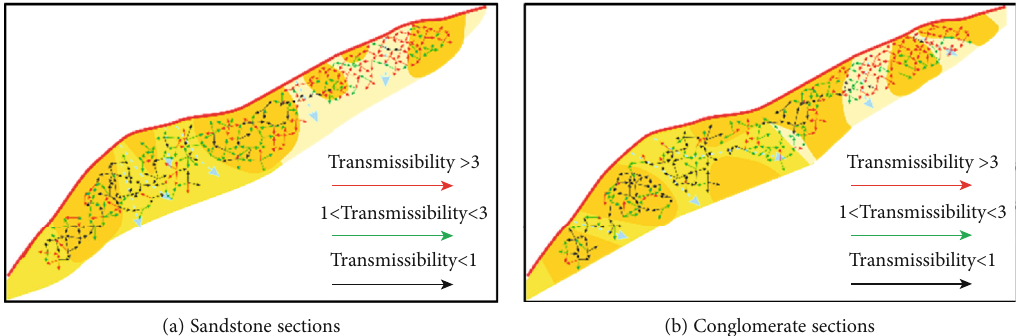
Figure 11: Reservoir interwell connectivity fi eld.